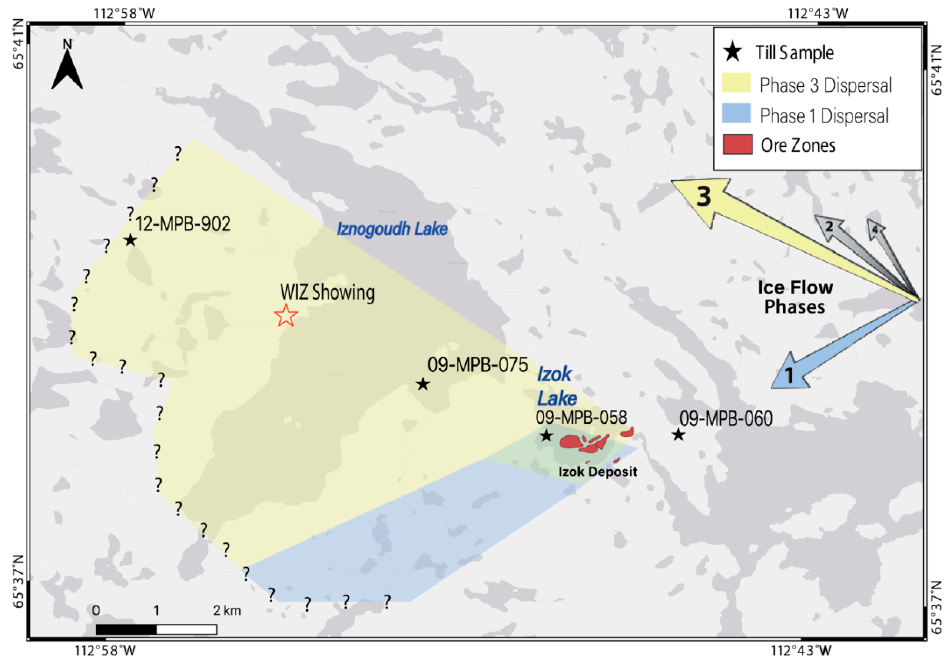
Figure 2. Location of the four till samples used in this study. Arrows indicate relative ice flow chronology (1 = oldest) and vigor (arrow width) of flow events. Colored polygons depict the glacial dispersal fan for gahnite in the non-ferromagnetic 250–500 µm fraction of till heavy mineral concentrate (HMC), as interpreted by McClenaghan et al. [1]. Yellow polygon represents dispersal by the NW ice flow; blue represents dispersal by the older SW ice flow, and the question-marked border represents the terminal sampling distance beyond which data is not available.